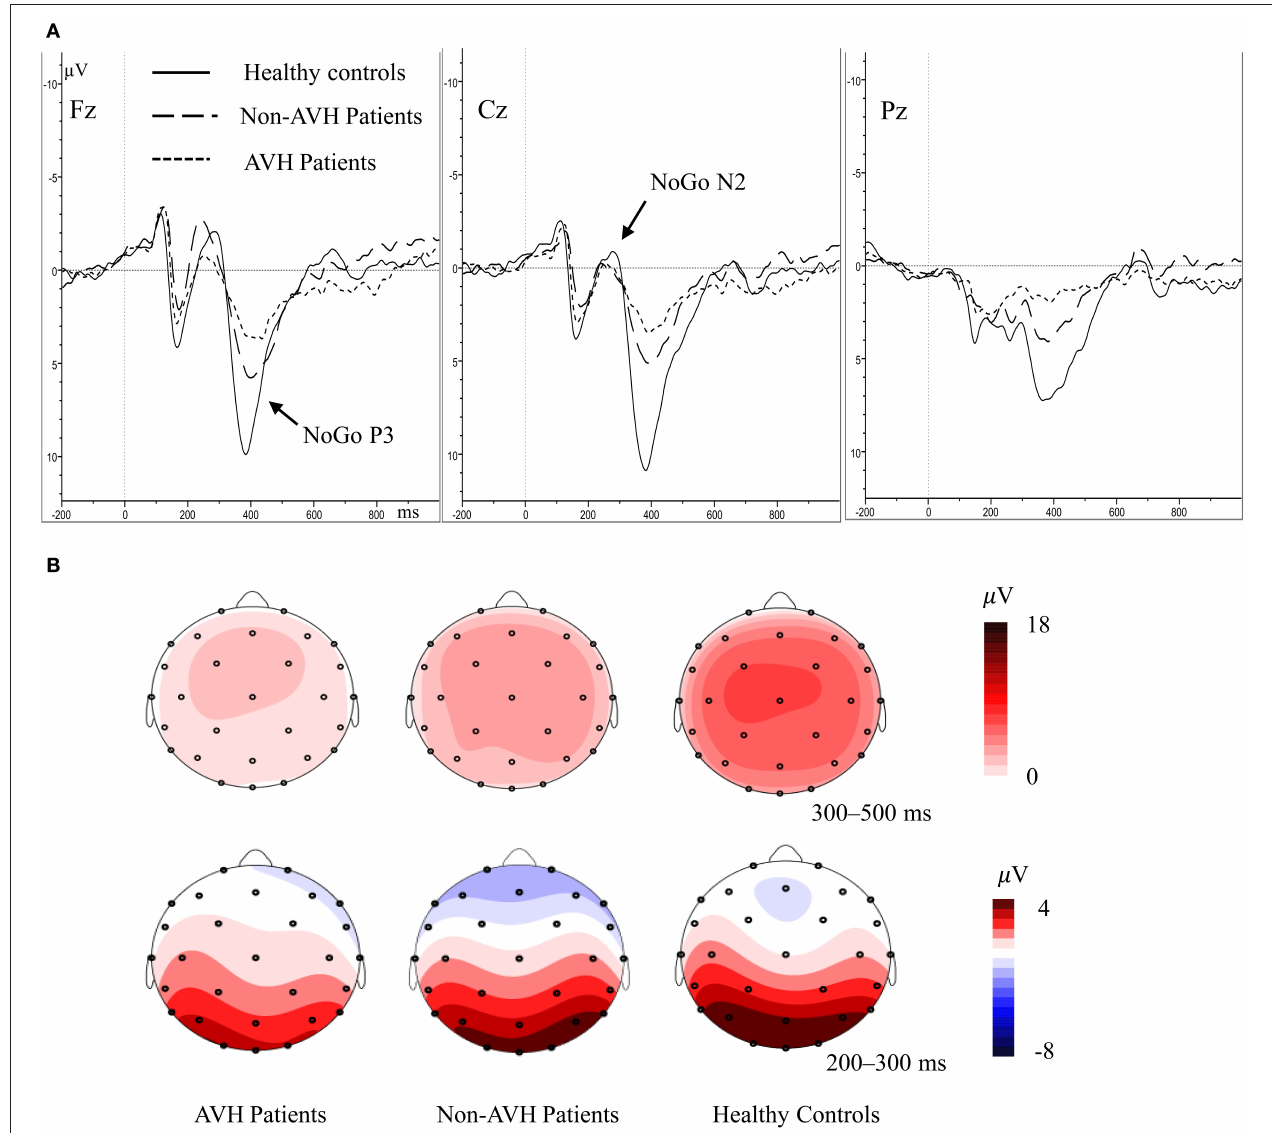
FIGURE 2 | (A) Averaged waveforms for NoGo trials in AVH patients, non-AVH patients, and healthy controls. (B) Grand-averaged topographical maps for NoGo trials within